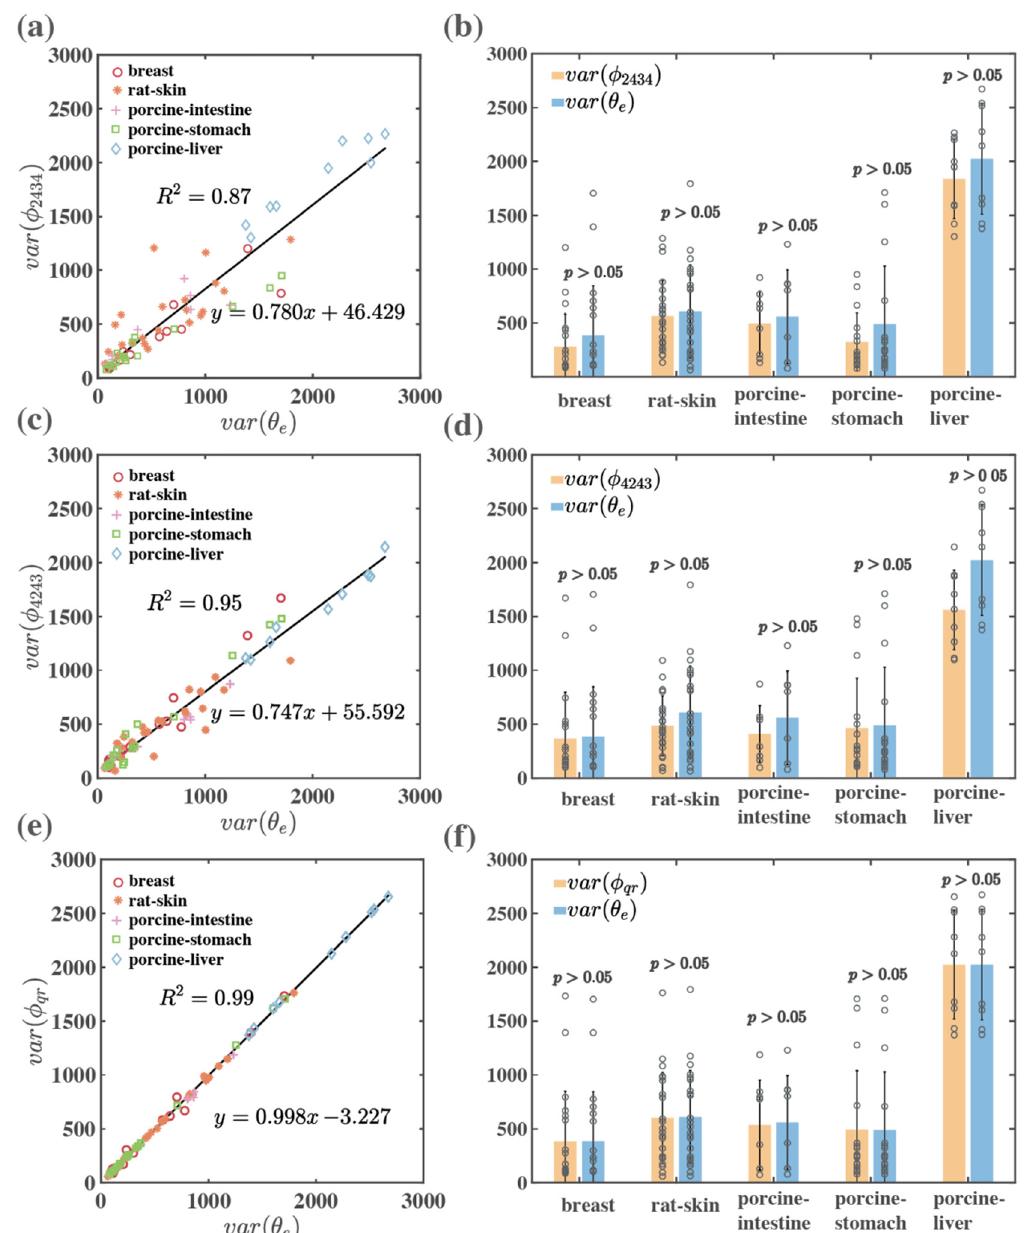
Figure 6. Comparison of linear birefringence fast axis orientation MMT and MMPD parameters of bulk tissue samples. ( a ) Variance of linear birefringence orientation MMPD parameters θ e plotted against its counterpart MMT parameter ϕ 2434 for correlation analysis with all five kinds of bulk tissue samples. ( b ) Statistical analysis bar chart of linear birefringence orientation MMPD parameter θ e and MMT parameter ϕ 2434 for each kind of bulk tissue samples. ( c ) Variance of linear birefringence orientation MMPD parameters θ e plotted against its counterpart MMT parameter ϕ 4243 for correlation analysis with all five kinds of bulk tissue samples. ( d ) Statistical analysis bar chart of linear birefringence orientation MMPD parameter θ e and MMT parameter ϕ 4243 for each kind of bulk tissue samples. ( e ) Variance of linear birefringence orientation MMPD parameter θ e plotted against its counterpart MMT parameter ϕ qr for correlation analysis with all five kinds of bulk tissue samples. ( f ) Statistical analysis bar chart of linear birefringence orientation MMPD parameter θ e and MMT parameter ϕ qr for each kind of bulk tissue sample.